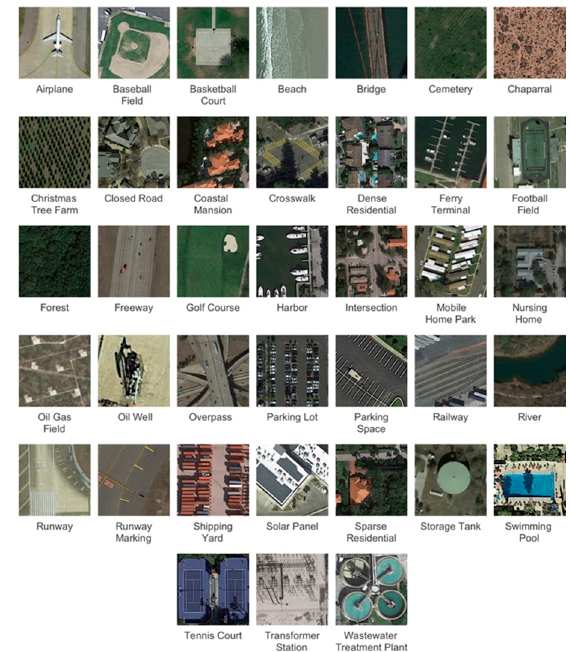
Figure 3. Illustration of the PatternNet. The PatternNet database covers 38 land-cover classes and one image of each class randomly selected from the PatternNet are shown.